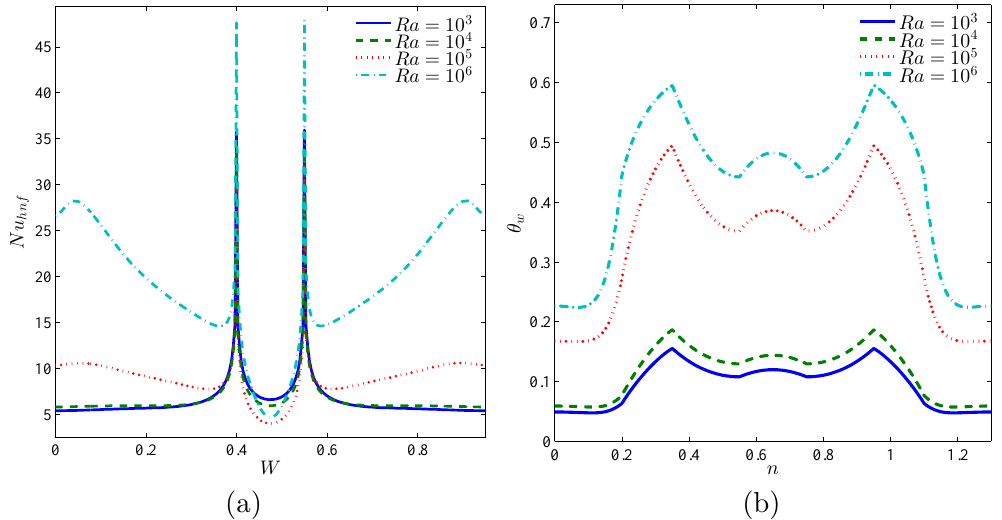
Figure 12. Evaluation of ( a ) the local Nusselt number interfaces with W and ( b ) local dimensionless temperature on the solid blocks with different Ra for hybrid nanofluids; φ = 0.02 and D =